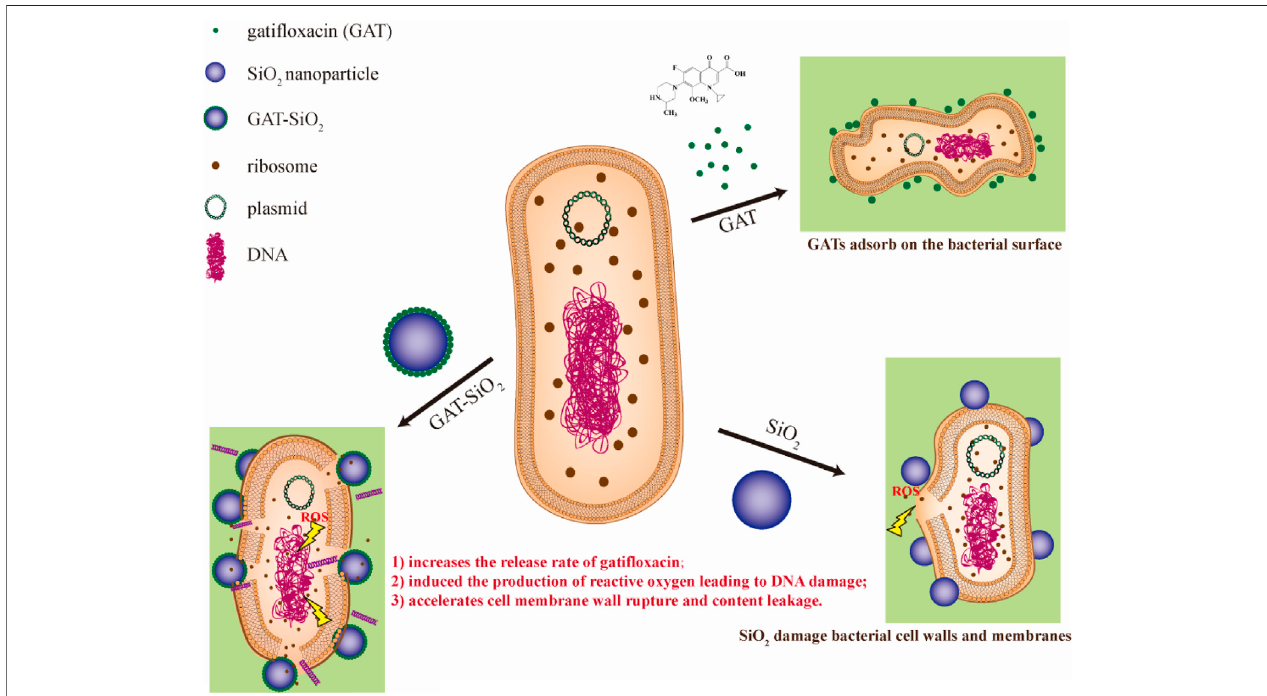
FIGURE 7 | Schematic diagram of synergistic antibacterial mechanism between nano-silica and gati fl oxacin.